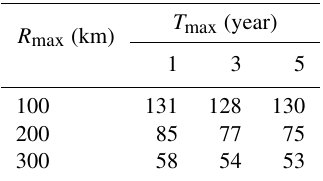
Table 1. Number of detected spatiotemporal clusters of flash flood disasters in China during 1950–2015 using different parameters, as